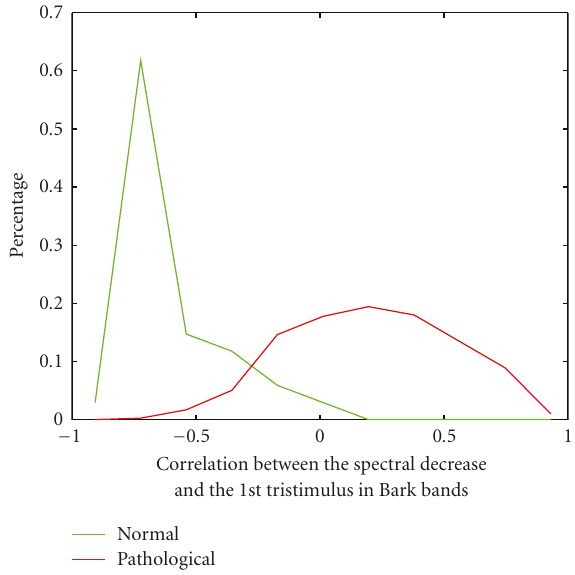
Figure 10: Distribution of the first discriminant correlation for the samples of the training set (green; normal class; red: pathological